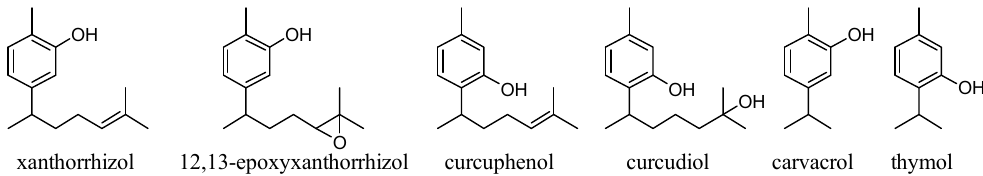
Figure 1. Bisabolane-type sesquiterpenoids and similar phenols from natural products.